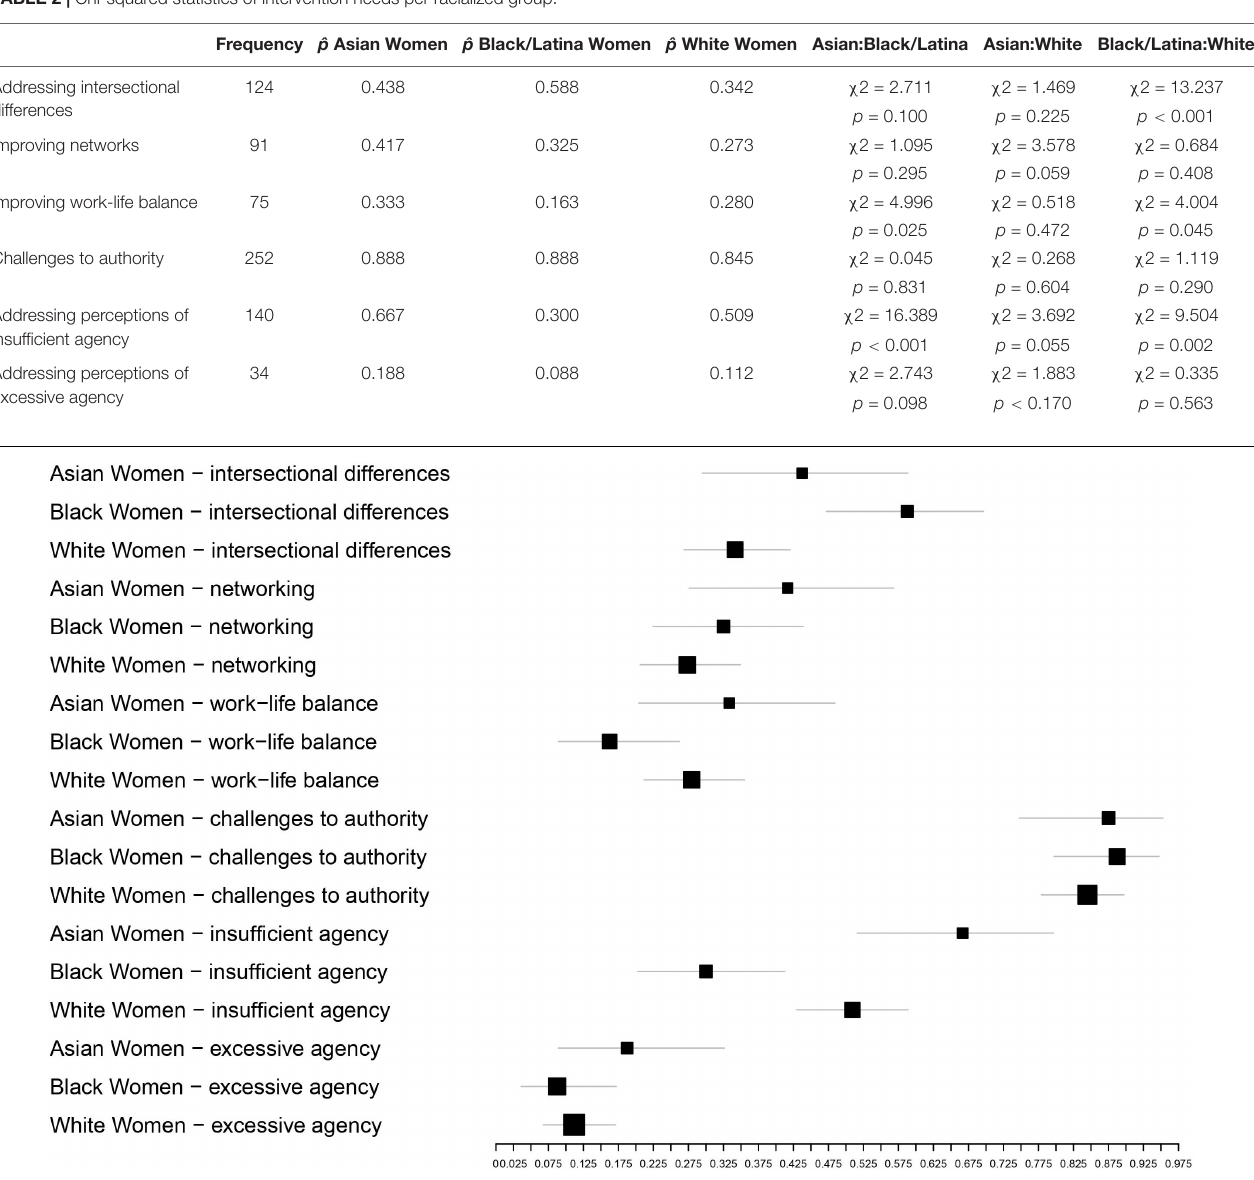
TABLE 2 | Chi-squared statistics of intervention needs per racialized group.